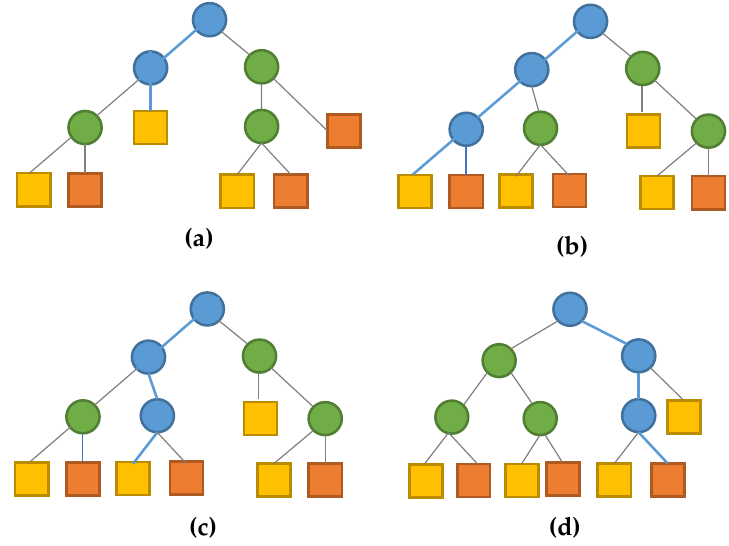
Figure 3. Graphical representation of classification trees. ( a ) yellow class prediction by the first path, ( b ) yellow class prediction by the second path, ( c ) yellow class prediction by the third way, ( d ) orange class prediction.